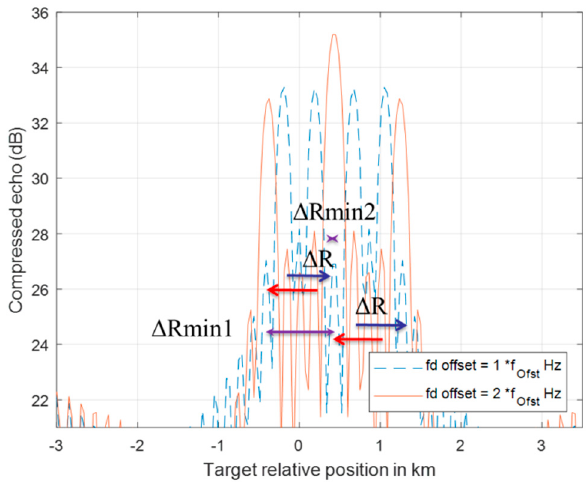
Figure 13. Two moving target MDSC of Figure 6 Case 2 scenario. The signal is traced from one Hz DSC (blue-dotted line) to two f d _o ff set Hz DSC (red line). It is the special case, which the grouping f d _offset Hz DSC (blue-dotted line) to two f d _offset Hz DSC (red line). It is the special case, which rule finds a wrong pair out of three determining processes. the grouping rule finds a wrong pair out of three determining processes.